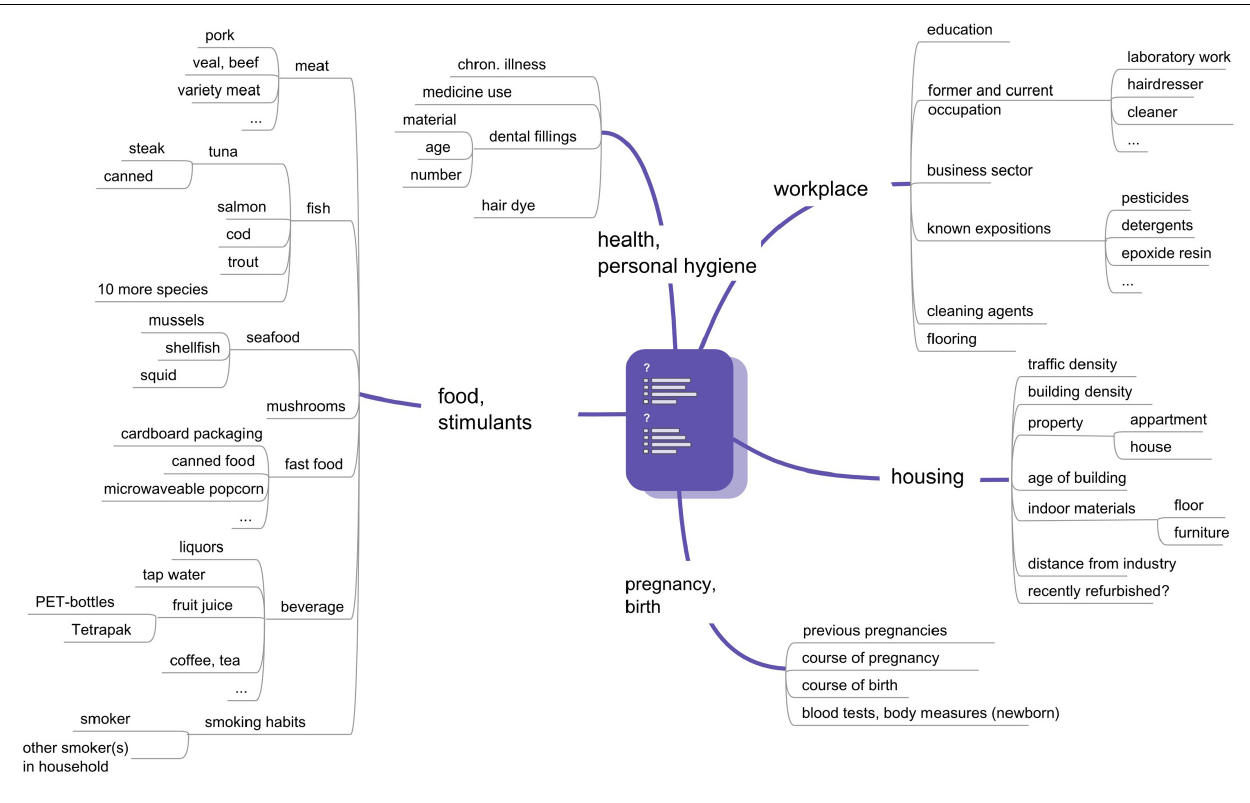
FIGURE 1 | Questionnaire items of the UmMuKi study.